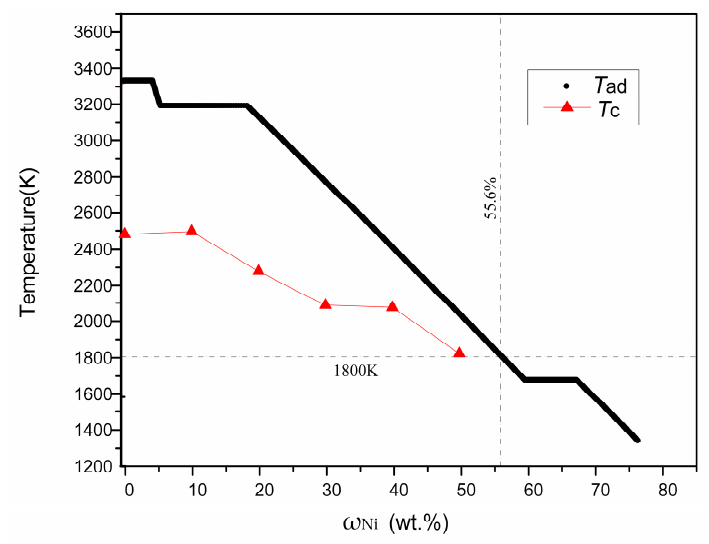
Figure 3. Variation in the T ad and T c of the Ni–Zr–B 4 C system with various Ni